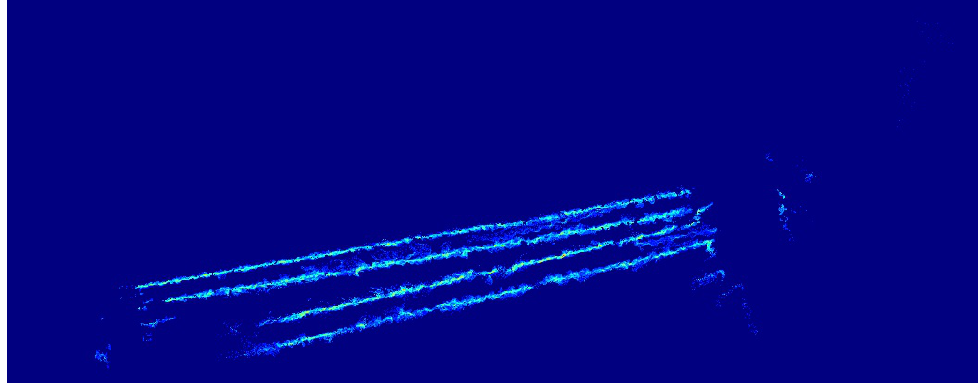
( a ) Top-view coloured image, based on the Jet colour-map array, of the canopy volume. Colder or hotter colours mean lower or higher volumes, respectively.